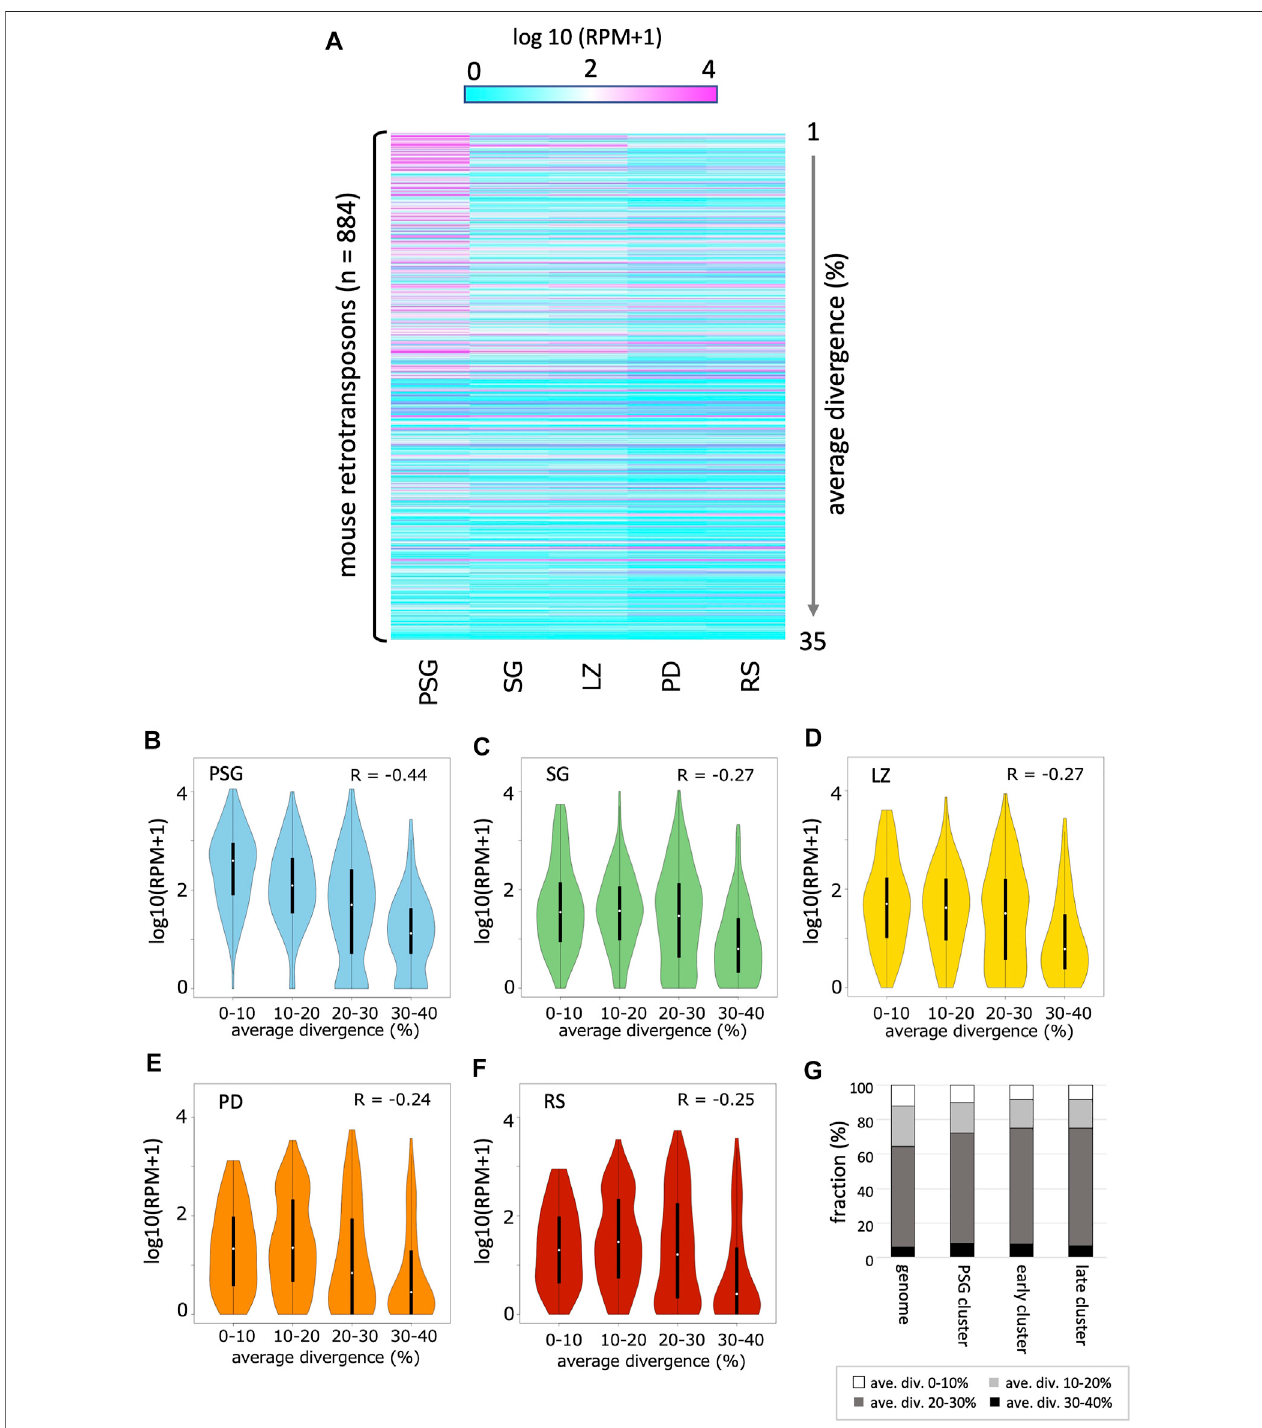
FIGURE4| Expressionpro fi leofretrotransposon-derivedpiRNAs (A) AheatmapshowingthepiRNAexpressionlevelsfor884retrotransposonspeciesidenti fi edin the mouse genome (by RepeatMasker). The order of retrotransposons is sorted by the mean values of divergence from the respective consensus sequences. The evolutionally younger a family is, the smaller its value is. (B – F) Violin plots showing the expression levels of retrotransposons categorized by their average divergences in PSG (B) , SG (C) , LZ (D) , PD (E) and RS (F) . In each panel, the fi rst (0 – 10%), second (10 – 20%), third (20 – 30%), and fourth (30 – 40%) groups contain90, 249, 377, and 168 retrotransposons, respectively. (G) Retrotransposon contents in PSG, early, and late piRNA clusters as well as whole genome. Retrotransposons are grouped according to their average divergences.